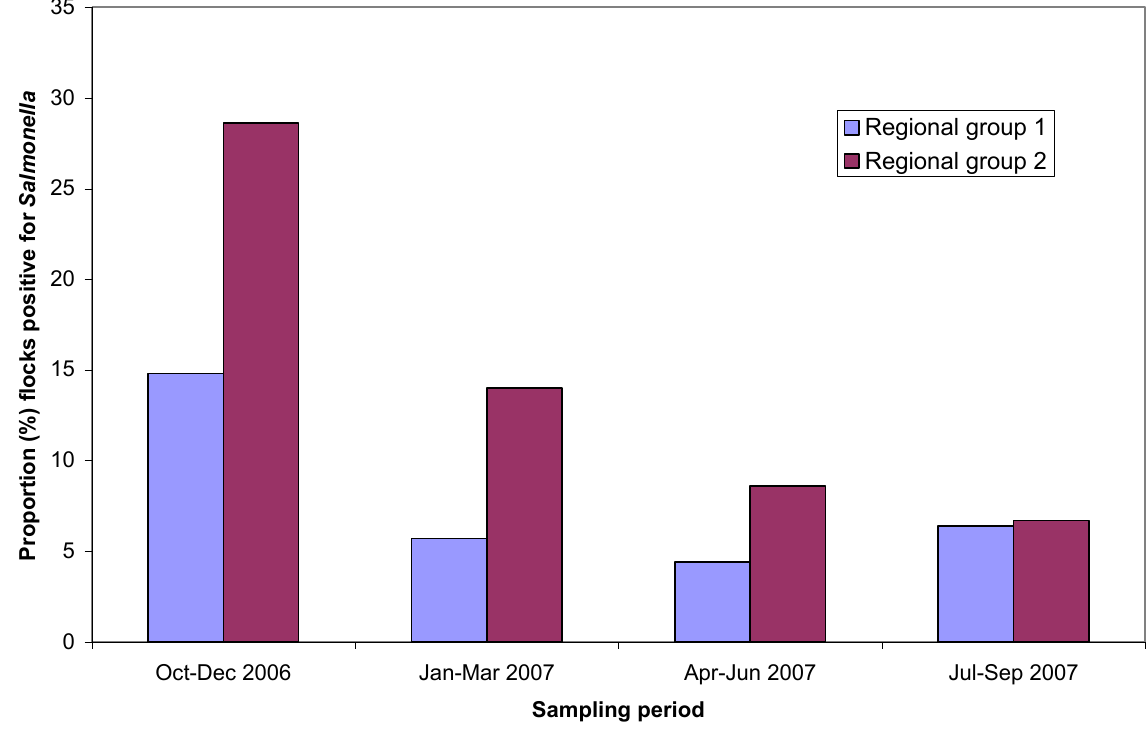
Figure 2. Proportion flocks positive for Salmonella by time of sampling (shown in quarters of the year). Regional group 1 comprises all federal states beside the federal state with the highest number of flocks sampled (regional group